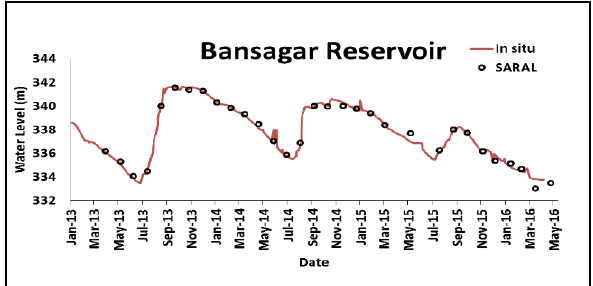
Figure 5. Altika water level time series for Bansagar (2013-18).